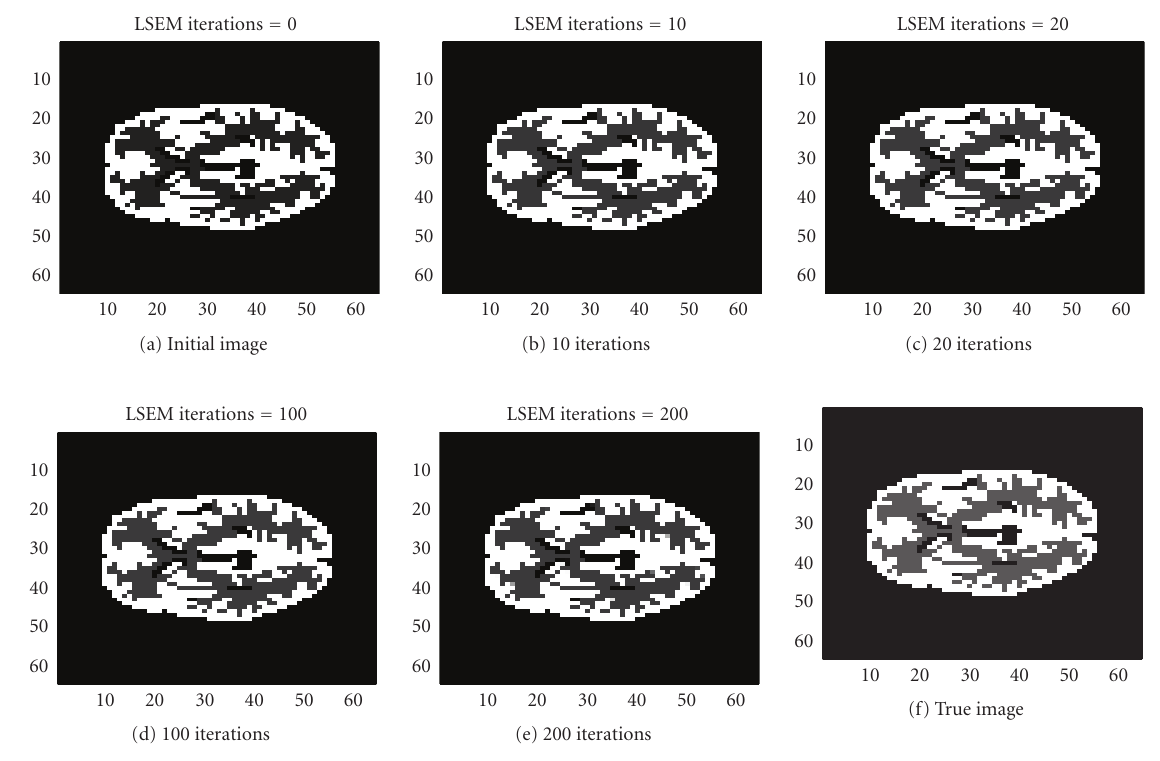
Figure 15: 64 × 64 segmented MRI slice of the brain.